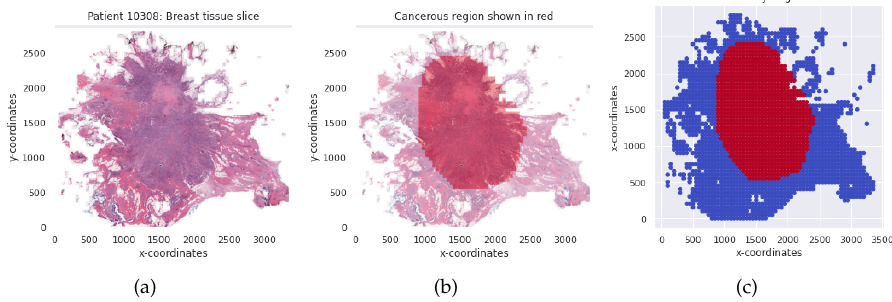
Figure 4. ( a ) Breast tissue slice for an IC-NST subject. ( b ) The red colored mask shows the cancerous region. ( c ) Binary target per tissue slice for the IC-NST